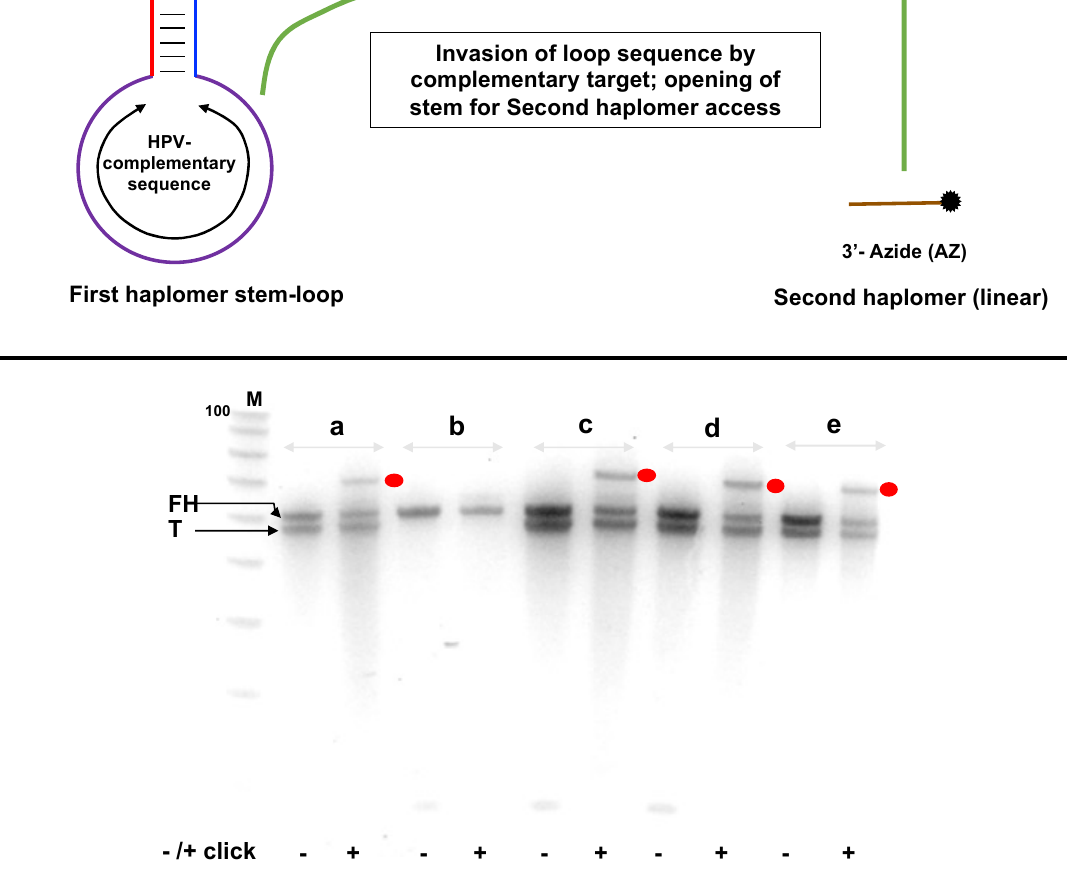
Figure 4. Locked-NATS strategy for overcoming template titration. ( A ) Design and structure of a Locked-NATS system. The First (or “bottle”) haplomer (Lk-HPV1) consists of a constant stem self-hybridizing duplex defining a variable loop sequence, which comprises the complement to any designated target (shown here as a DNA equivalent to a sequence from human papillomavirus (HPV)). The 5 ′ end of the first haplomer is modified to bear a reactive linear hexanyl group. In this example, a shorter oligonucleotide, the Second (linear) haplomer (Lk-HPV2), has a 3 ′ azide modification. In the presence of specific target template, hybridization occurs which destabilizes (“unlocks”) the stem duplex, exposing a single-stranded region that is complementary to the Second haplomer. Hybridization of the second haplomer with the “open” First haplomer results in the hexanyl/azide groups falling into spatial proximity, promoting their mutual click reactions in conjunction with Cu(I) catalysis. ( B ) Locked-NATS demonstrations with template/haplomer system of A under varying reaction conditions (a–e), where each is finally treated with and without catalysts for promoting Cu (I) click reactions. Before use, the First haplomer bottle was subjected to a “pre-self-annealing”, to ensure maximal intra- molecular formation of the bottle structure. For this purpose, 1250 pmol of the first HPV haplomer bottle in 25 µL in 10 mM Tris-HCl pH 7.5/10 mM MgCl 2 /50 mM NaCl/1 mM dithioerythritol was subjected to 5 min/80 °C treatment, followed by rapid chilling at 0 °C for at least 10 min. From this, 1 µL (50 pmol) was used for the experimental tests. When the second haplomer was added, it was at an equimolar concentration with the first haplomer bottle (2 µM). Conditions: (a) First haplomer + target template incubated 2 h/37 °C; then second haplomer added for an additional 1 h/37 °C, (b) as for